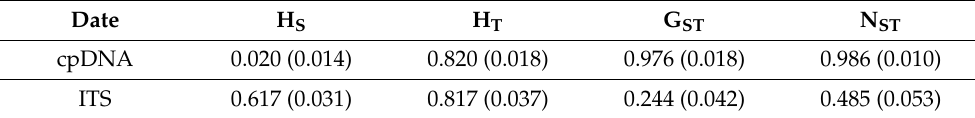
Table 2. Estimation of gene diversity (H S , H T ) and gene differentiation (G ST , N ST ) across all popula- tions of Stilpnolepis centiflora .